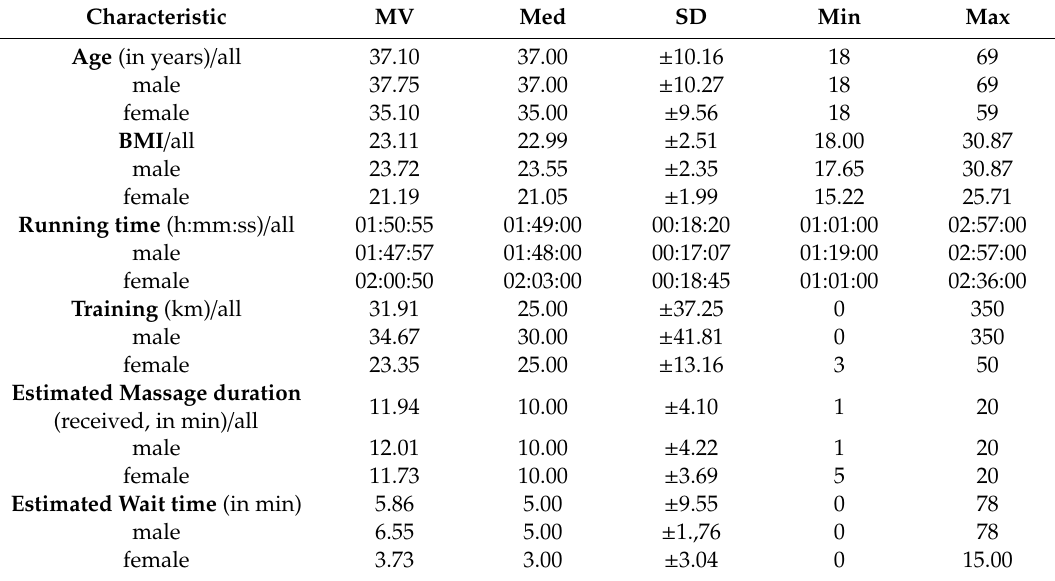
Table 1. Participant characteristics. MV = mean value, Med = median, SD = standard deviation, Min = minimum, Max = maximum and BMI = body mass index.